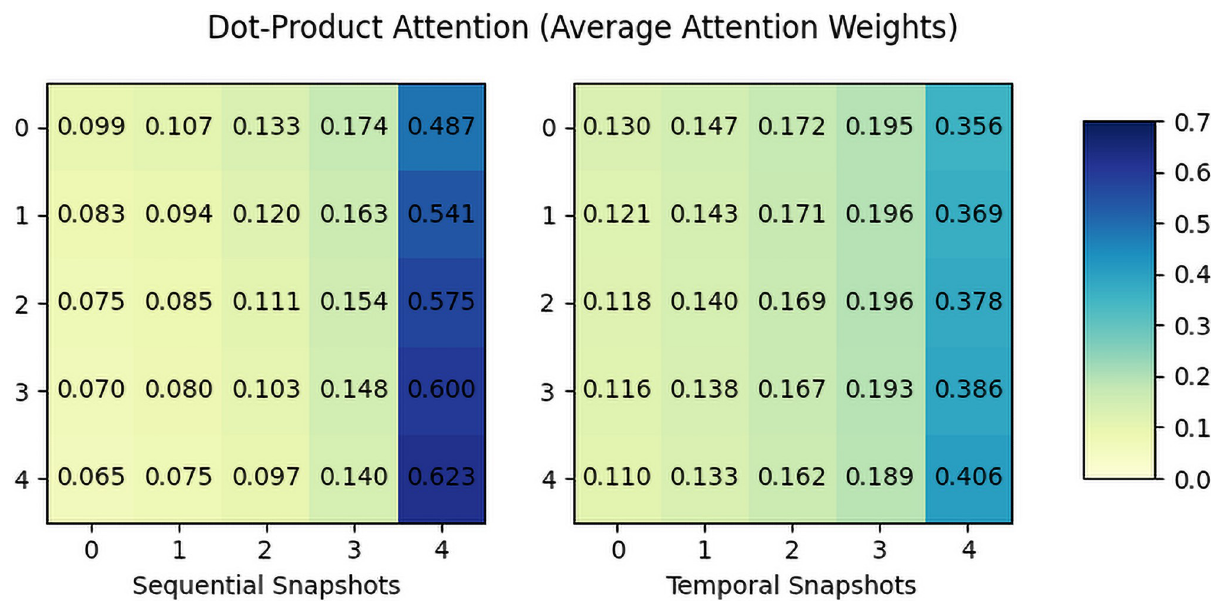
Fig 7. Average attention weights of dot-product attention on Twitter16